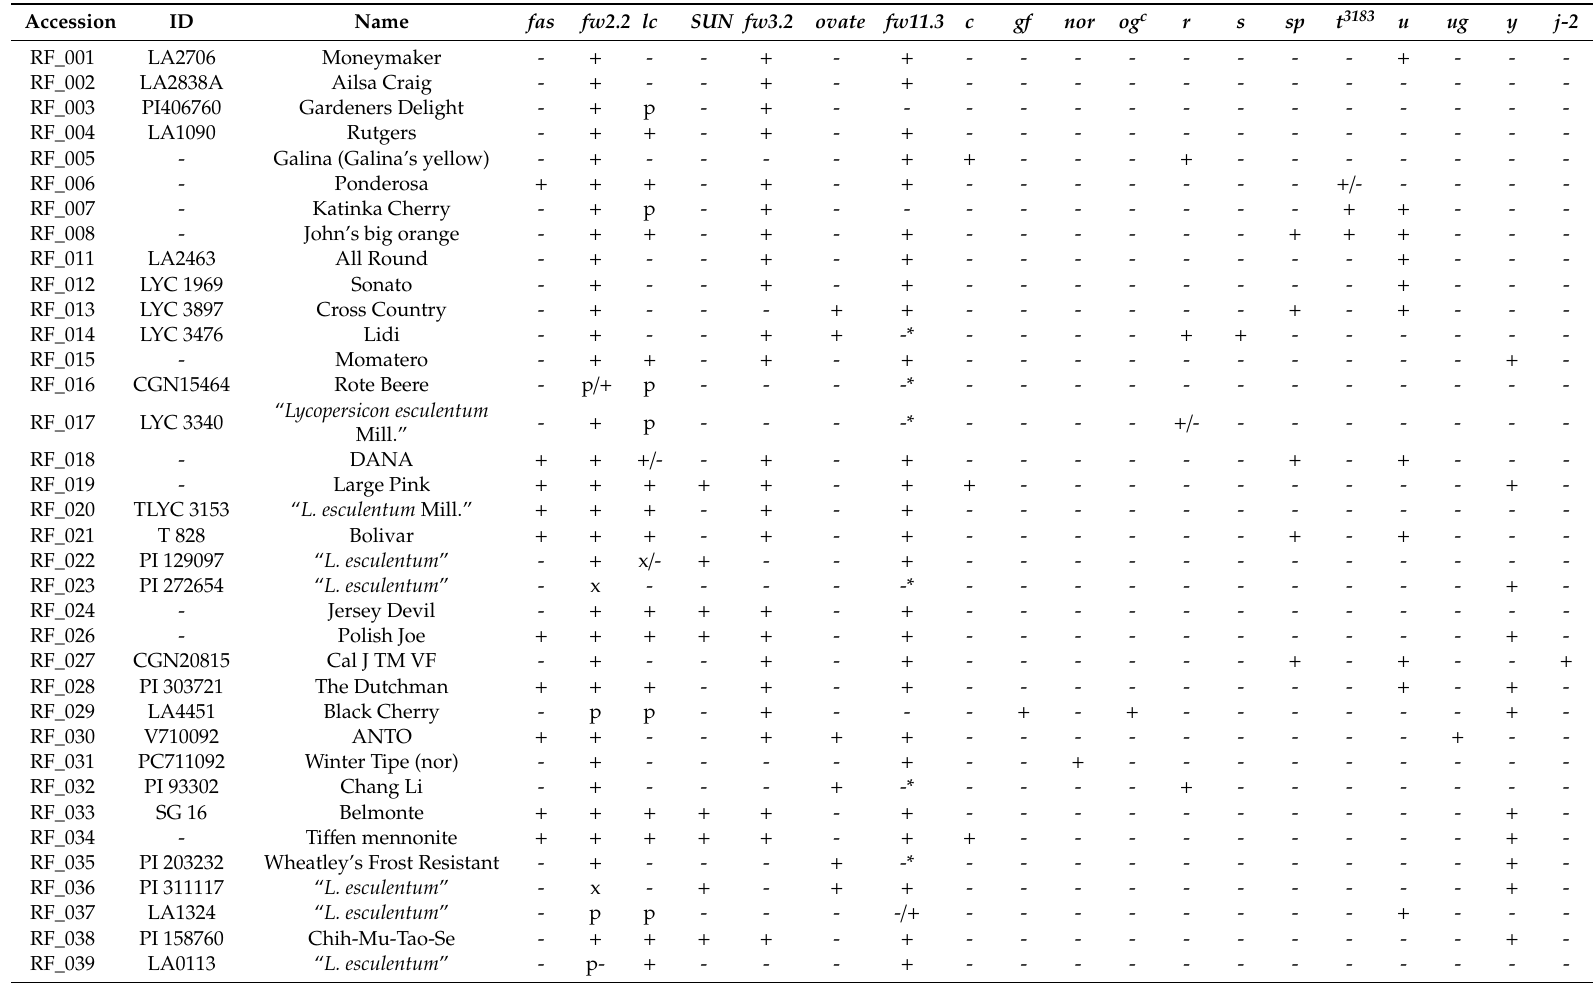
Table 2. Detected mutations or variants in the resequenced